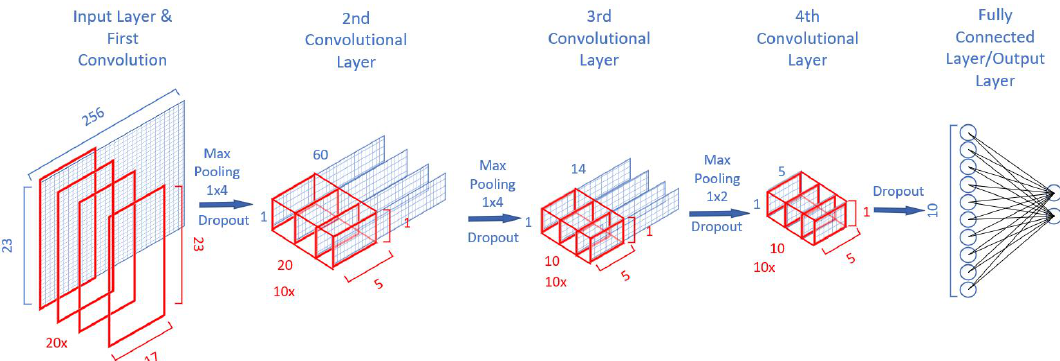
Figure 2. Schematic depiction of the CNN architecture showing the convolutional layers with their respective input matrix (blue rectangles) and kernels (red rectangles). Input is a 23 × 256 matrix. Between each convolutional layer, a dropout layer and max pooling layer is placed. Output are the two classes ictal and